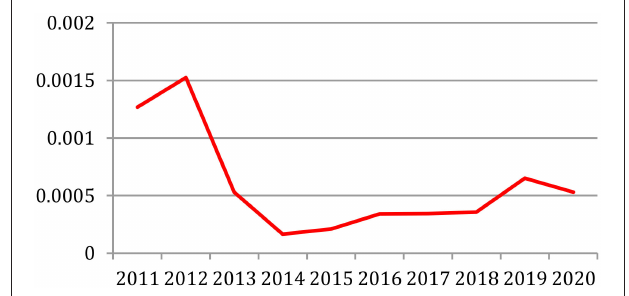
FIGURE 38 | Evolution of the distance between prediction and observation over the years.